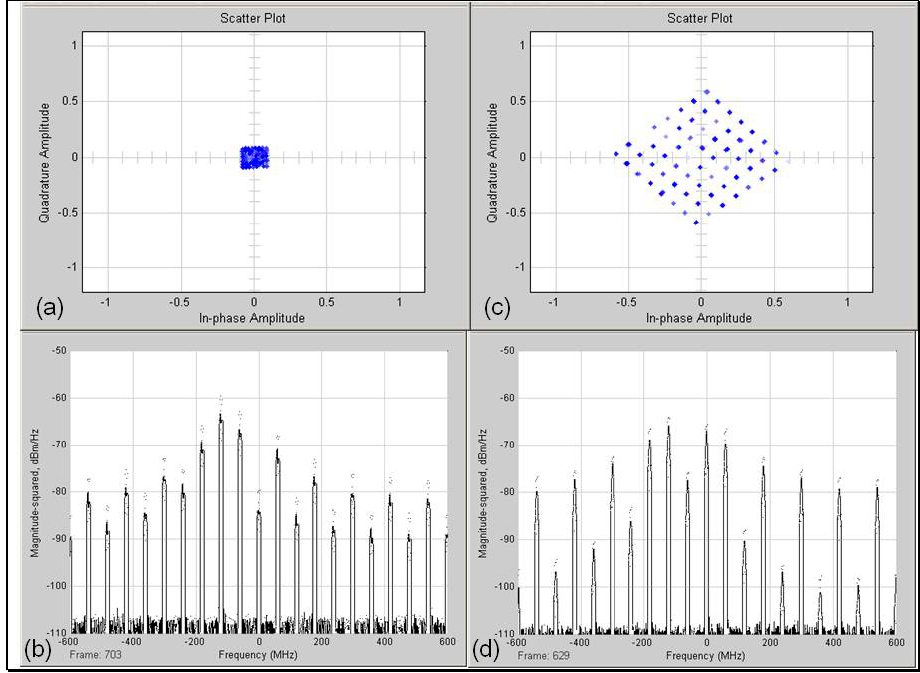
Figure 12. Separate OAM modes with shift by 2 F : ( a ) constellation of OAM8, ( b ) spectrum of OAM8, ( c ) constellation of OAM1, ( d ) spectrum of OAM1.